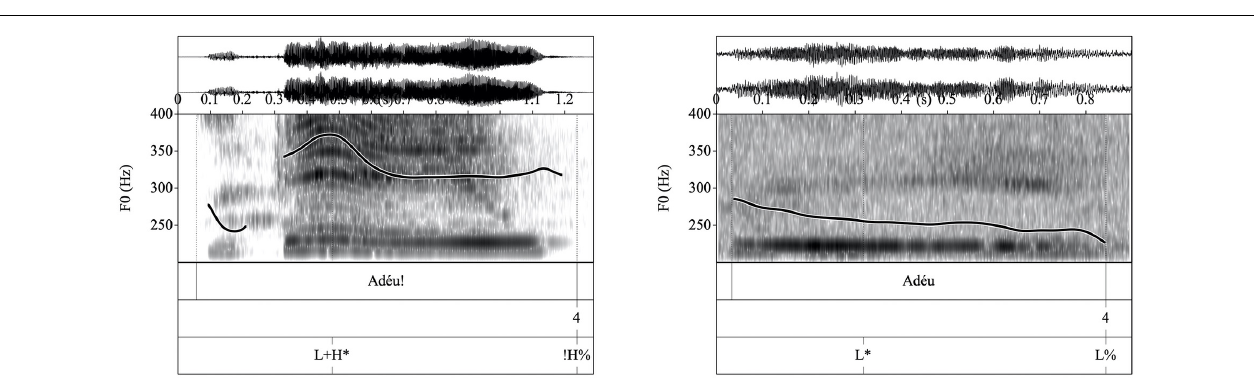
FIGURE 1 | (Left) Waveform, spectrogram and F0 trace for the question “ Tu vas a classe de música? ” “Are you taking music class?” scored 2 for prosody and produced with two prenuclear L* + H pitch accents and a L + H*H% nuclear configuration. (Right) Waveform, spectrogram and F0 trace for the same question, this time scored 1 for prosody and produced with two prenuclear L* + H pitch accents and a L + H*L% nuclear configuration, which is typical for statements.